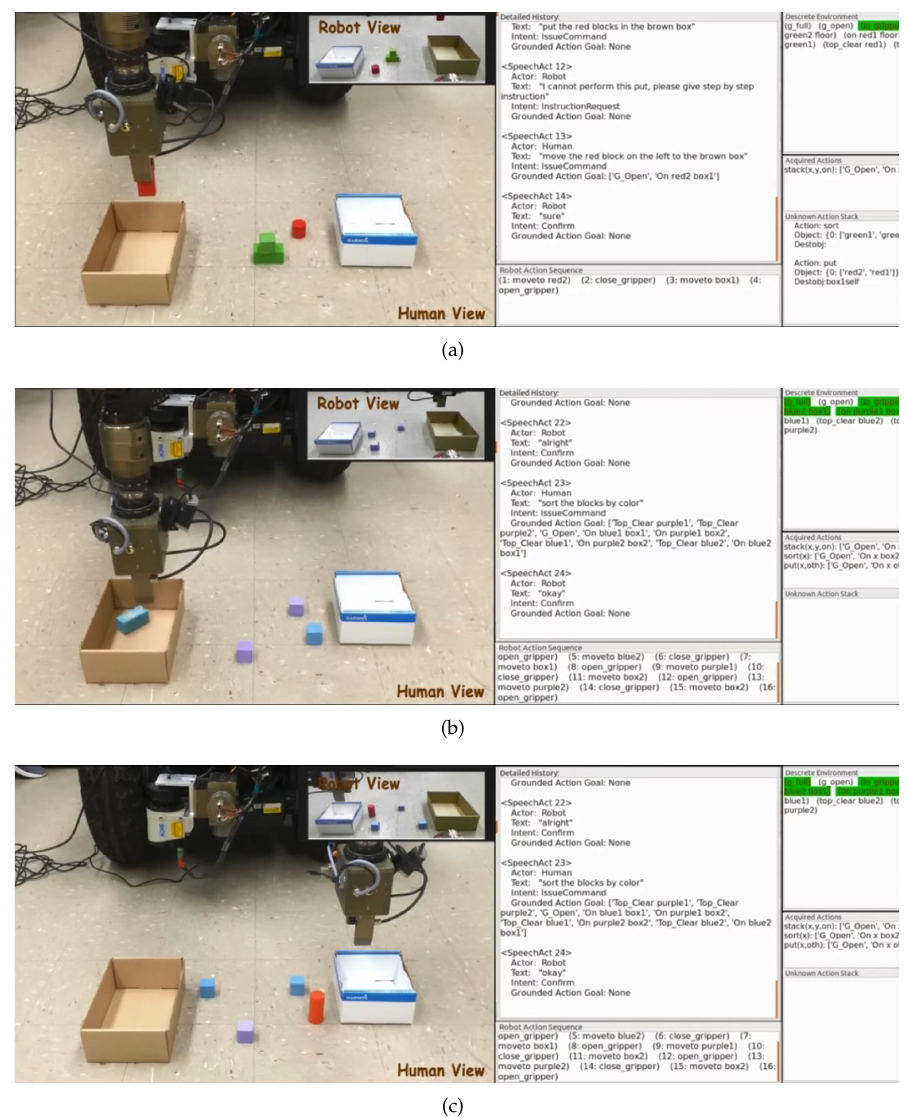
Figure 12. A demonstration of programming robots’ “sort” task by NL. ( a ) shows the scenario for teaching the robot a new task of sorting by color; ( b ) is a new environmental setup for testing; ( c ) shows that the robot could generalize the learned knowledge to the task of sorting by